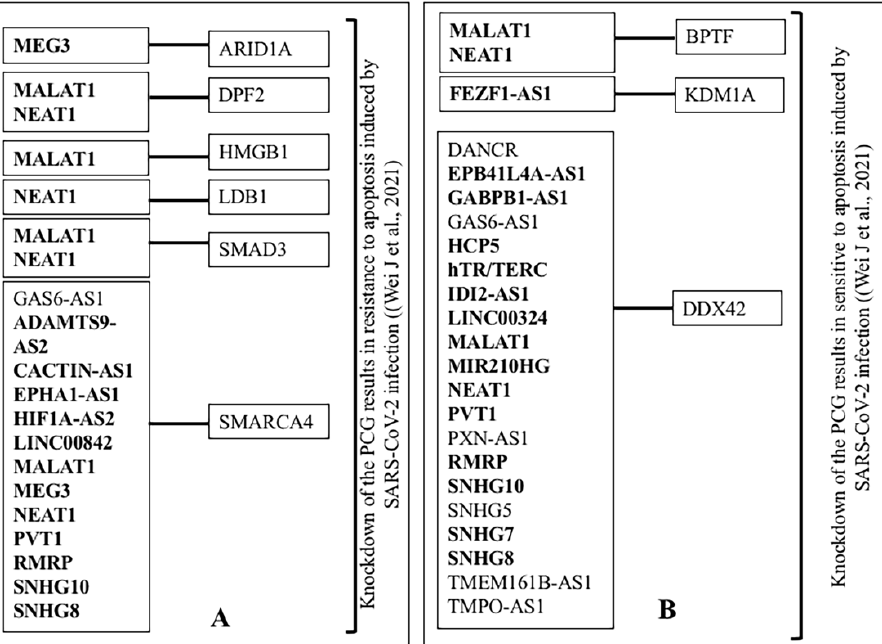
Figure 6. Representative result of CRISPR screening data from [106] is shown. Effects of knockdown of interacting partners of deregulated lncRNA in SARS-CoV-2 infected cells. Horizontal lines connecting two boxes indicate the interaction. LncRNA in bold face represents the increased expression in SARS-CoV-2 infected cells, ( A ): resistance to apoptosis, ( B ): sensitive to apoptosis. The same lncRNA interacting with different PCG might act as pro-viral or antiviral.